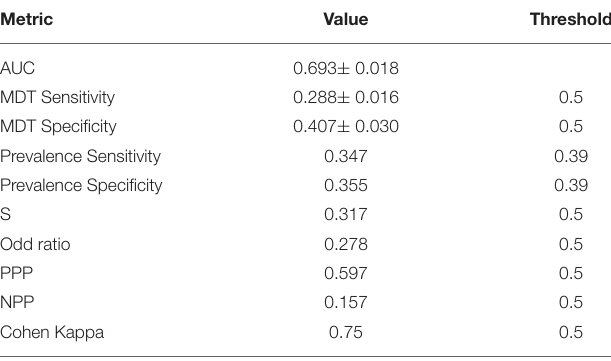
TABLE 3 | Pooled model validation